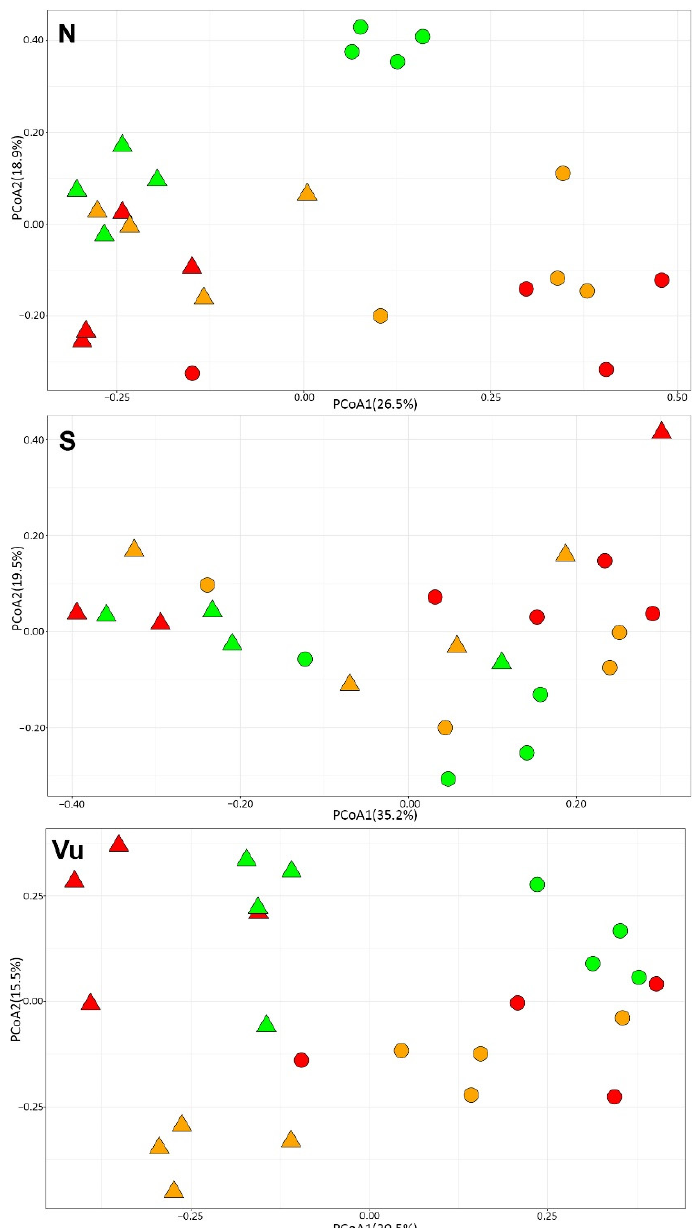
Figure 3. Principal Coordinates Analysis (PCoA) of the mollusc assemblages sampled in N, S, and Vu sites. Colours indicate pH conditions: green = ambient pH; orange = low pH; red = extremely low pH. Microhabitats are indicated through circles (Canopy) and triangles (Bottom).